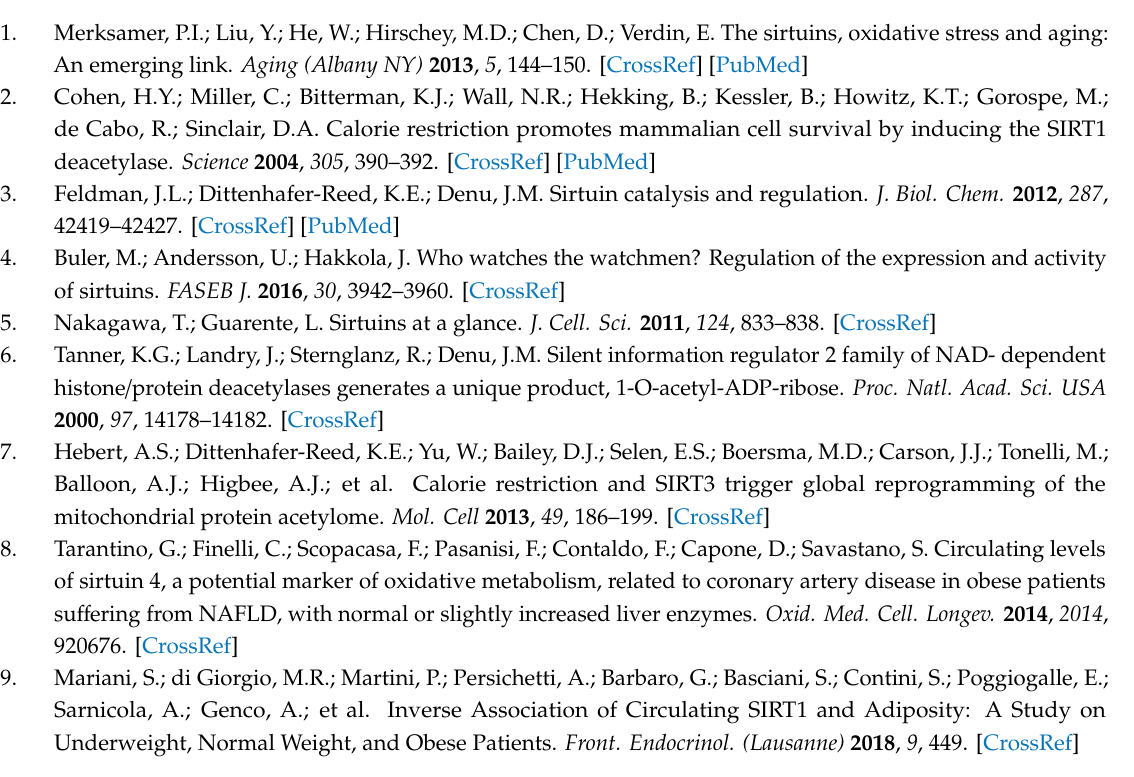
Figure S1 : Flow chart of the study population; Table S1: Sequences of qRT-PCR-Primers; Table S2: Correlations of SIRT-activities with di ff erent